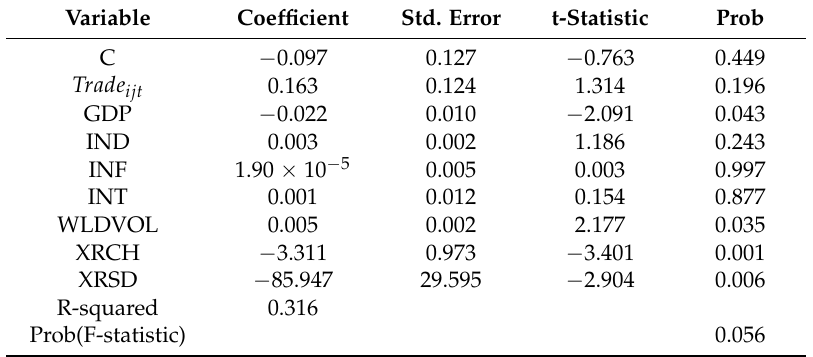
Table 8. Determinant of Stock Market Co-movement between Pakistan and